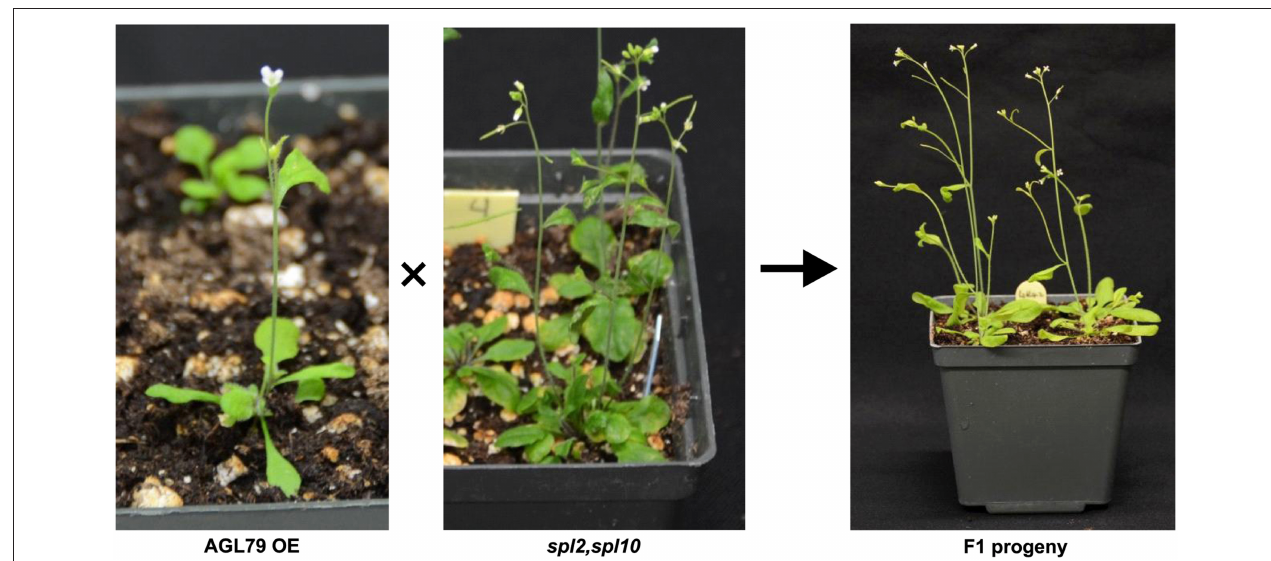
FIGURE 8 | Complementary experiment to investigate relationship between AGL79 and SPL10 . WT phenotype was observed when crossing ( AGL79 overexpression plant and spl2spl10 double mutant. Bar =